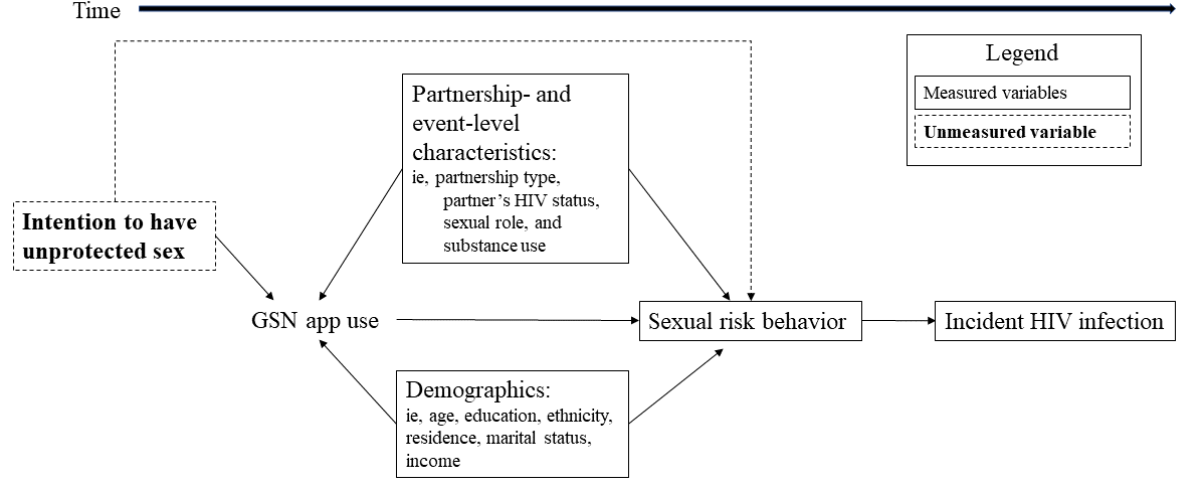
Figure 1. Directed acyclic graph showing the hypothesized pathway from geosocial networking (GSN) app use to sexual risk behavior and incident HIV infection, highlighting the unmeasured confounding effect of intention to have unprotected